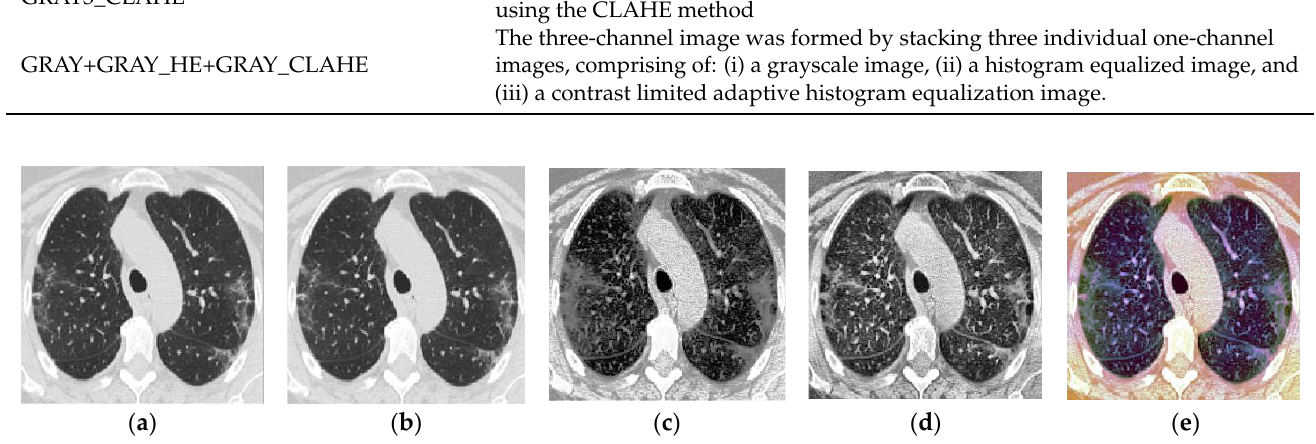
Figure 2. Sample image after data pre-processing for each image representation: ( a ) RGB, ( b ) GRAY3, ( c ) GRAY3_HE, ( d ) GRAY3_CLAHE, ( e ) GRAY+GRAY_HE+GRAY_CLAHE. Table 2. Description of the image representations. Descriptions